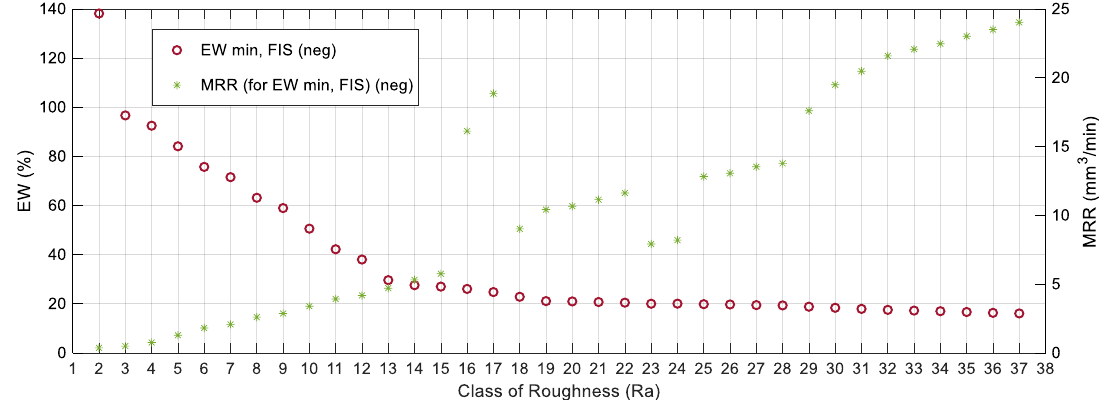
Figure 19. Values obtained from the technological table with the fuzzy inference system for the strategy of minimum electrode wear using negative polarity.